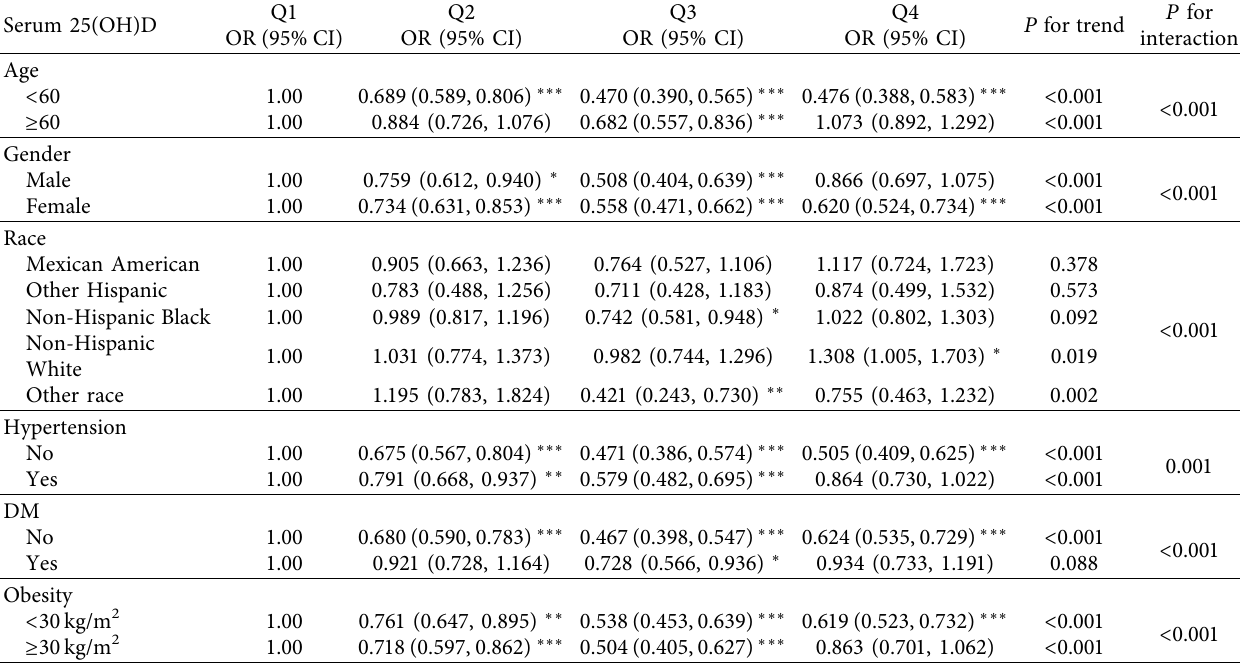
Table 3: Subgroup analysis for associations between serum 25(OH)D and the risk of